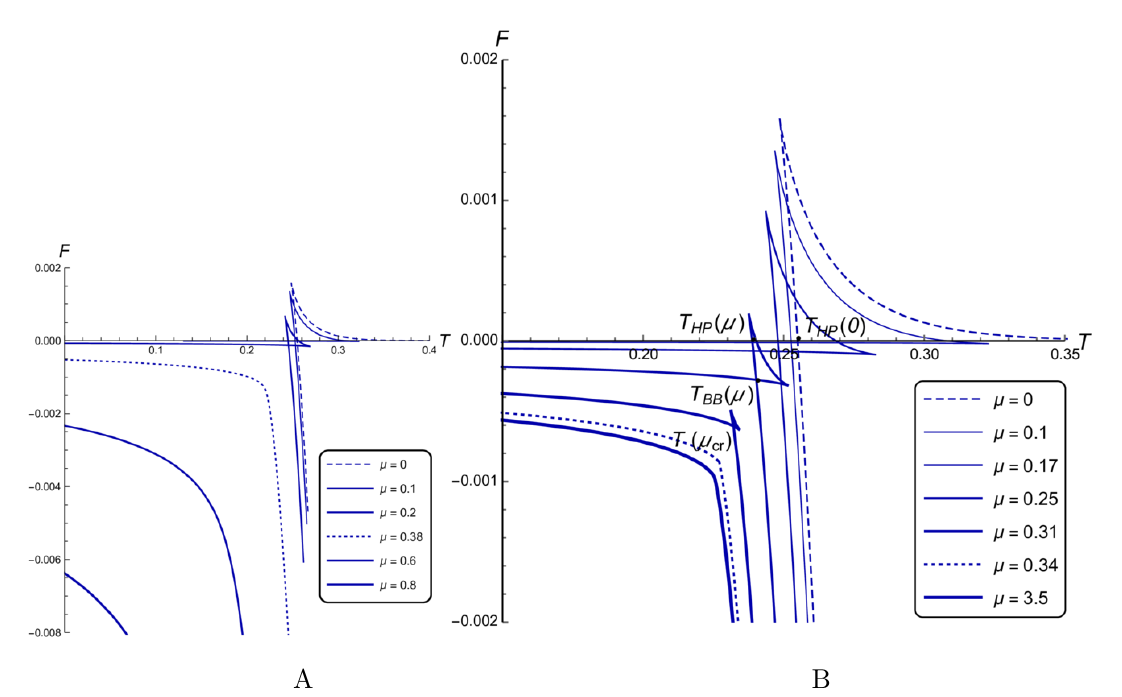
Figure 28 . The black hole free energy F ( T ) for c = (cid:0) 1 and di(cid:11)erent (cid:22) in anisotropic case, (cid:23) = 4 : 5, (A) and its zoom near F = 0